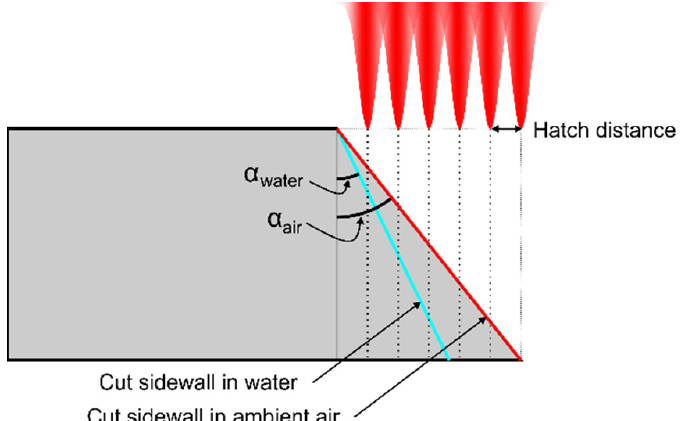
Figure 8. Schematic of the side view of the glass plate. Above the glass plate, a cumulative laser intensity profile is shown. Dashed lines (normal to the glass surface) extrapolated from the cumulative laser intensity peaks indicate positions where concavities were formed on the inclined cut wall. Ridges were formed between the